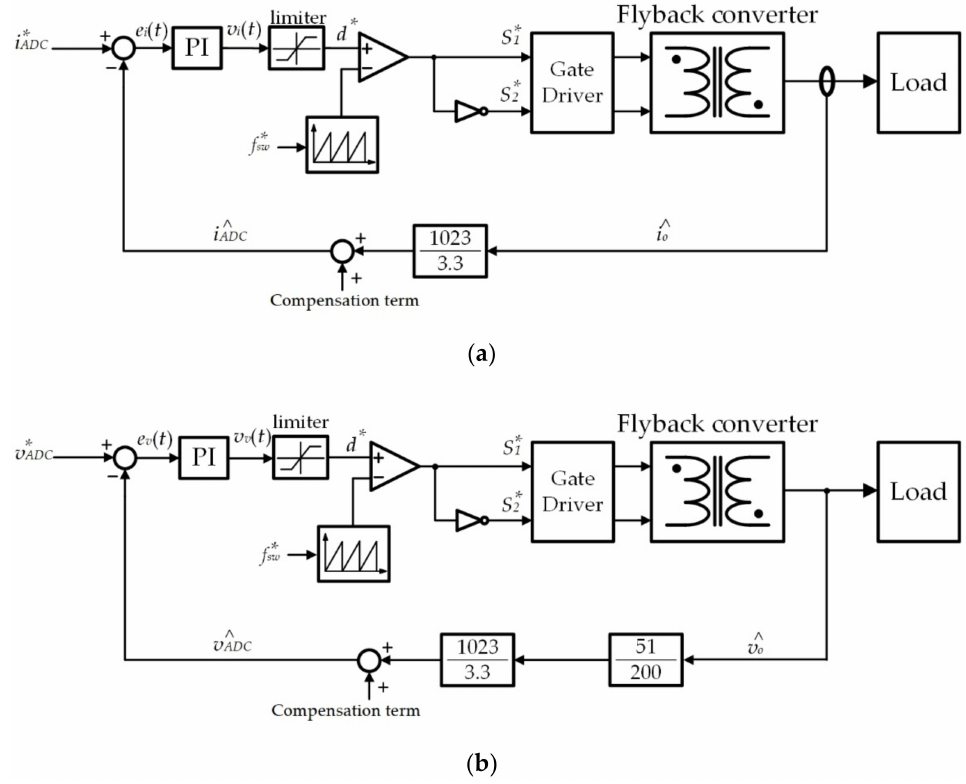
Figure 8. Diagram of the dual-closed-loop control system: ( a ) current closed-loop; ( b ) voltage closed-loop.